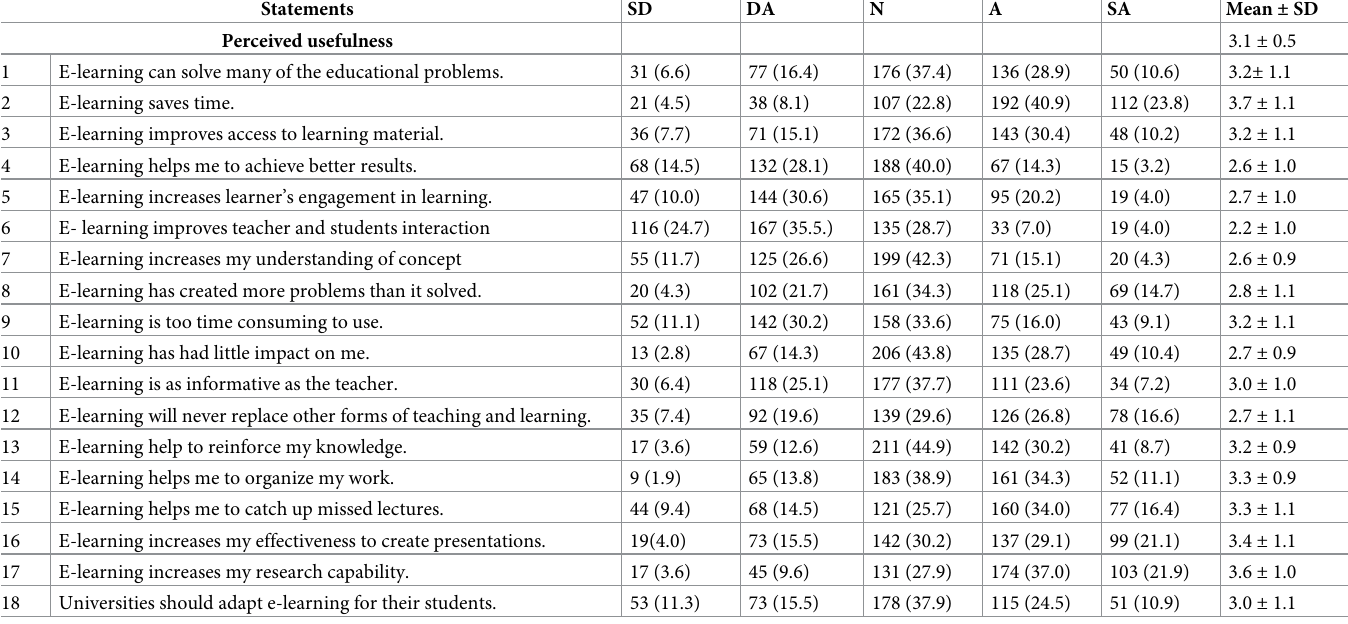
Table 3. Perceived usefulness (n =